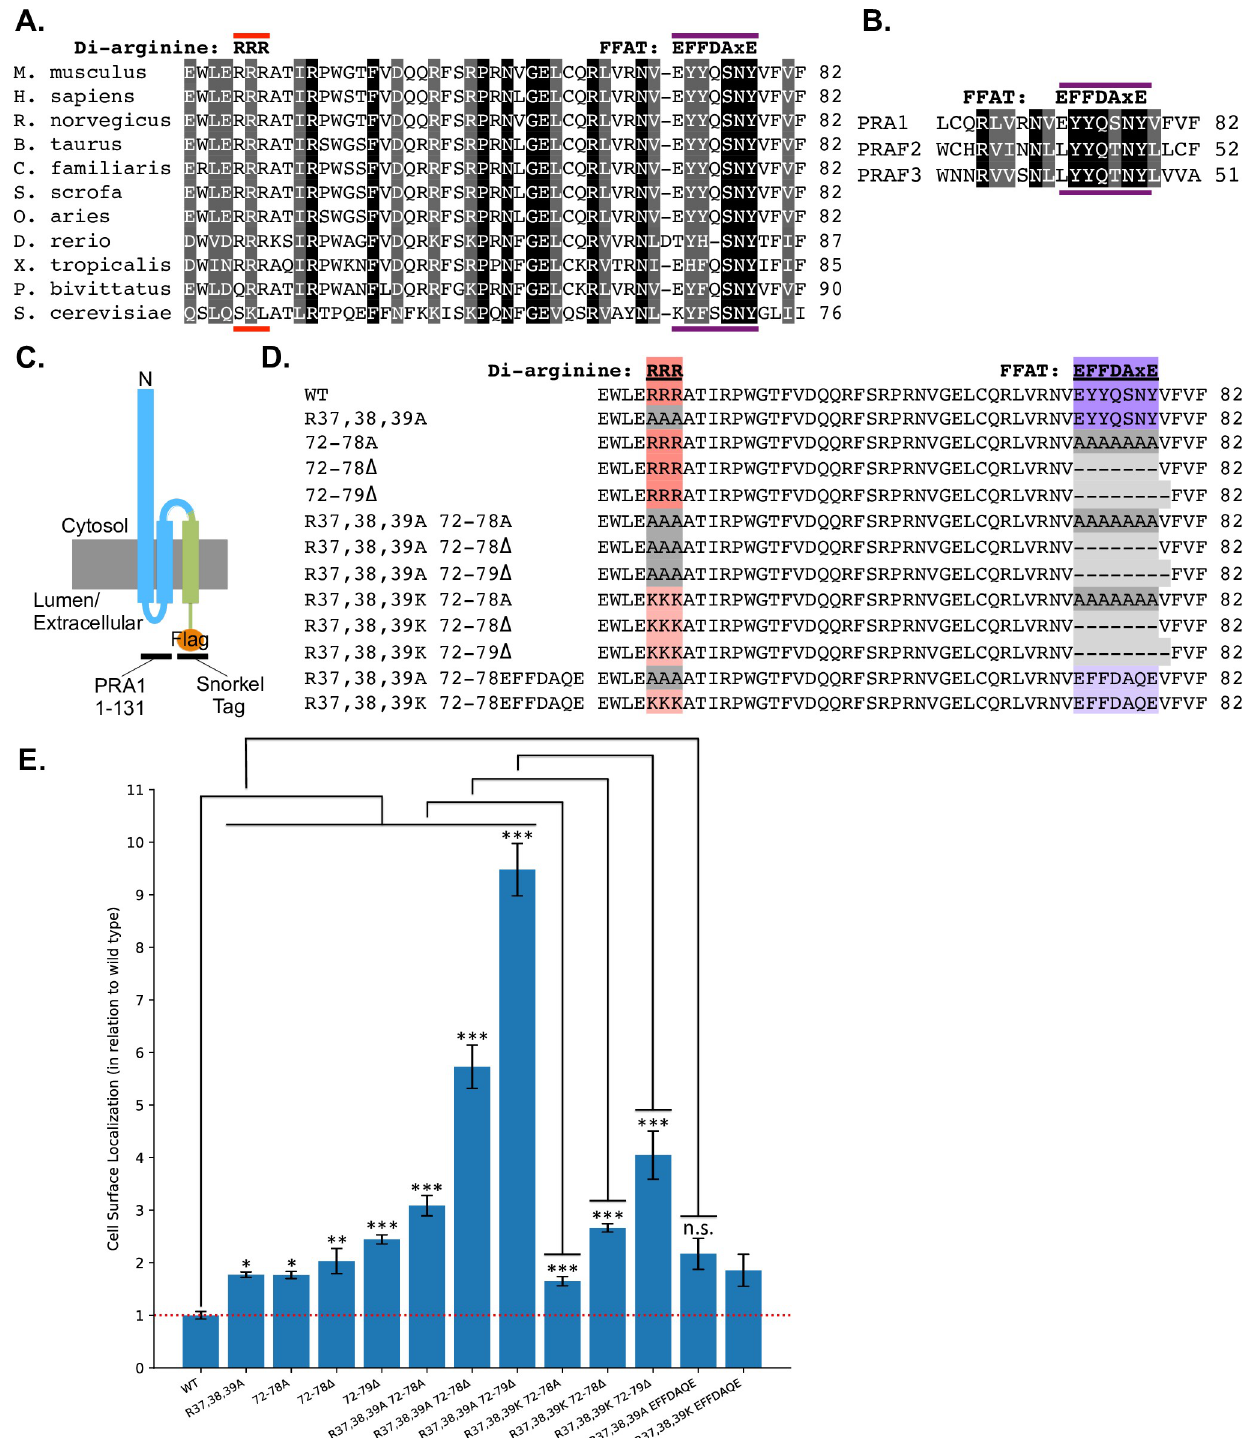
Fig 3. Targeted mutation of the PRA1 cytosolic N-terminal region reveals that di-arginine and FFAT-like motifs retain PRA1 constructs intracellularly. A cell surface assay carried out using COS-7 cells demonstrates that ER retention of a PRA1 construct with incomplete Golgi targeting information (amino acids 1–131) is driven by both di-arginine and FFAT-like motifs. (A) Alignment of PRA1 homologs shows that the di-arginine motif and the FFAT-like motif double aromatic residue signature are conserved in higher eukaryotes. (B) Alignment of all three mammalian prenylated rab